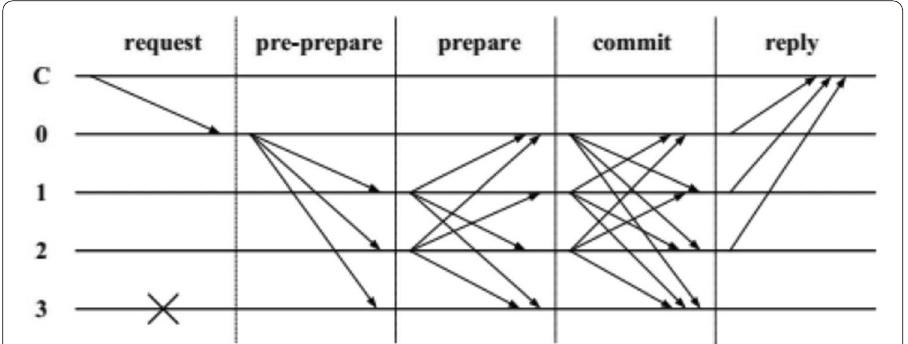
Fig. 7 PBFT algorithm flow; Illustration of the process of PBFT algorithm